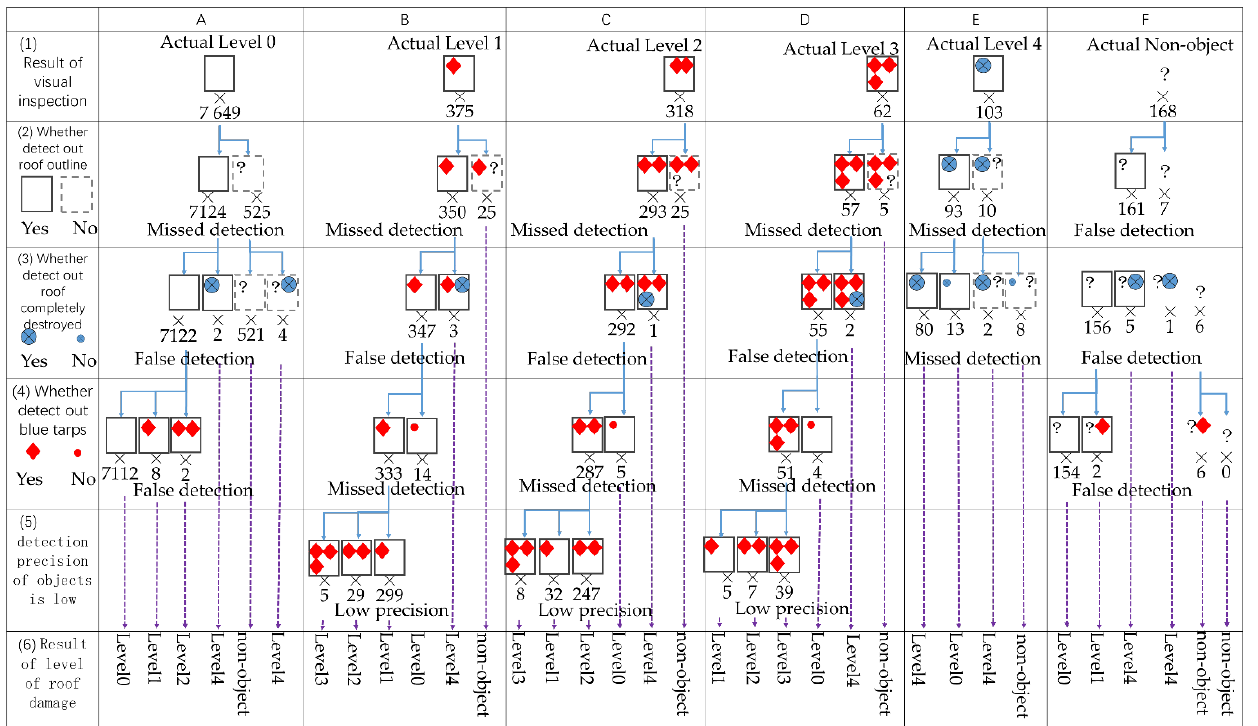
Figure 15. Statistical chart for classification of the level of roof damage. the column A–E is the process of level classification from actual level 0–4 to each classification level. The column F is the process of level classification frome actual non-object to each classification level.